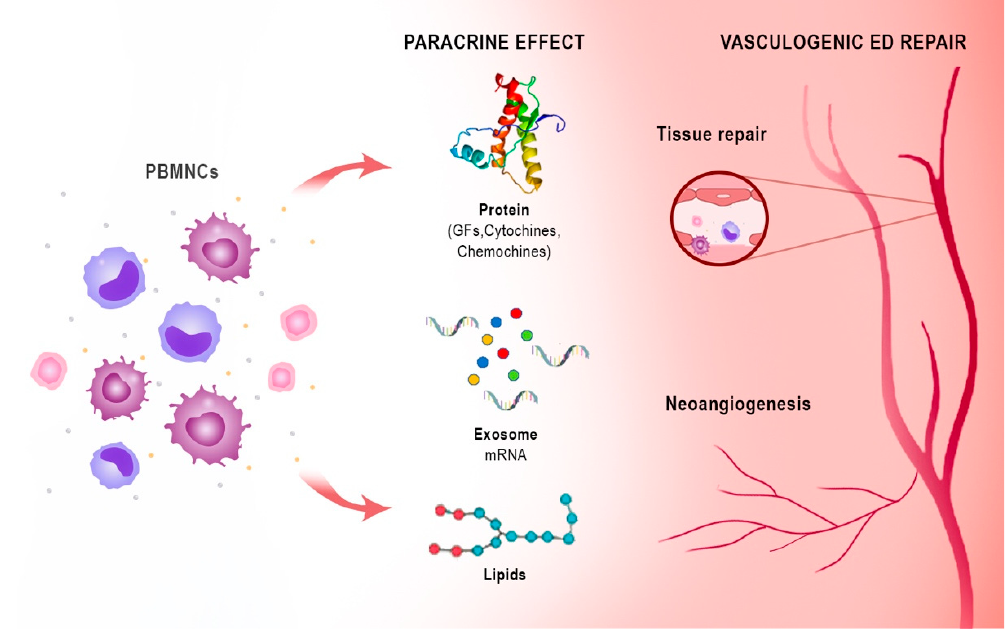
Figure 3. Immune-centric revolution: vasculogenic repair ED. PBMNCs: peripheral blood mononu- clear cells. GFs: growth factors. PBMNCs based on monocytes/macrophages and lymphocytes are a novel autologous cell therapy that has shown efficacy in angiogenesis and tissue regeneration through the action of bioactive substances with paracrine effects represented by different types of protein molecules such as growth factors, chemokines and cytokines, lipid mediators as oxidized phospholipids, microRNAs, and exosomes.